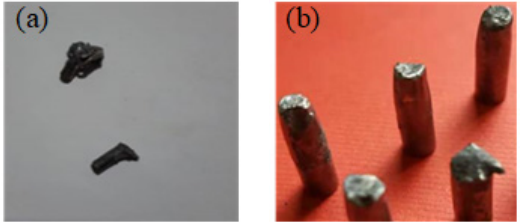
Figure 7. Photo of the 5.8 mm projectile core recovered after the target test. ( a ) The 5.8 mm projectile steel core recovered after the target test. ( b ) Photo of the recovered sandwich steel